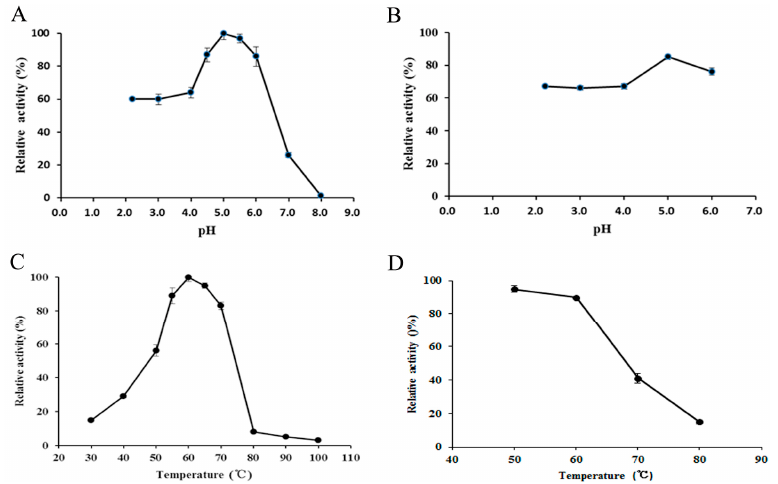
Figure 3. Impact of pH and temperature on α -galactosidase activity. ( A ) Effect of pH on α -galactosidase activity was determined at 50 °C in buffers with pH values from 2.0 to 8.0. The activity at pH 5.0 was defined as 100%; ( B ) pH stability of α -galactosidase activity was demonstrated by determining α -galactosidase activity under standard assay conditions following pre-incubation of the enzyme at room temperature for 2 h in buffers with pH values from 2.0 to 6.0. The activity of an untreated enzyme measured at pH 5.0 was defined as 100%; ( C ) Effect of temperature on α -galactosidase activity was examined at various temperatures in the range 30–100 °C. The activity at 60 °C was considered as 100%; ( D ) Thermostability of α -galactosidase activity was examined following pre-incubation of the enzyme at various temperatures ranging from 50 to 80 °C for 2 h. The activity of enzyme which had not been subjected to heating was defined as 100%. Data represent means ± SD ( n = 3).